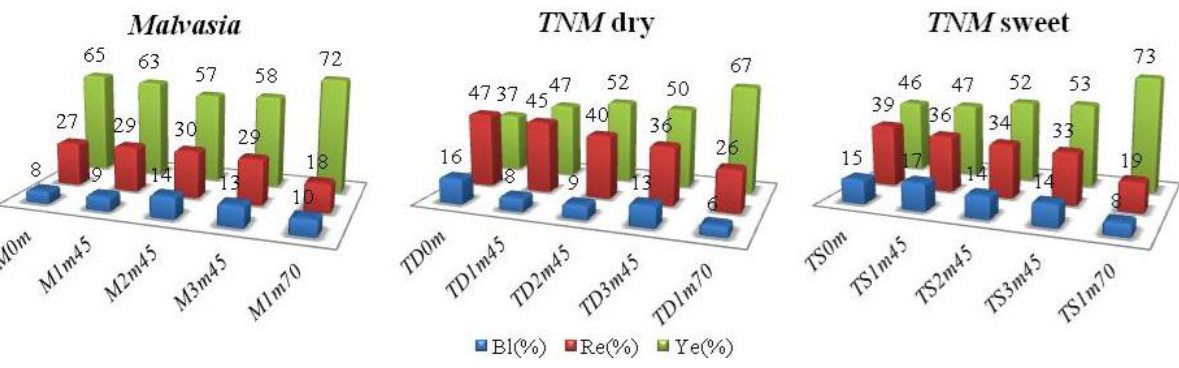
Figure 1. Glories parameters, %Ye , %Re and %Bl , of Madeira wines during the heating at 45 °C (3 months) and 70 °C (1 month). Sample identification: M , TD and TS stand for Malvasia , TNM dry and TNM sweet wines, respectively, while the following two digits correspond to the heating period and the last two represent the heating temperature.